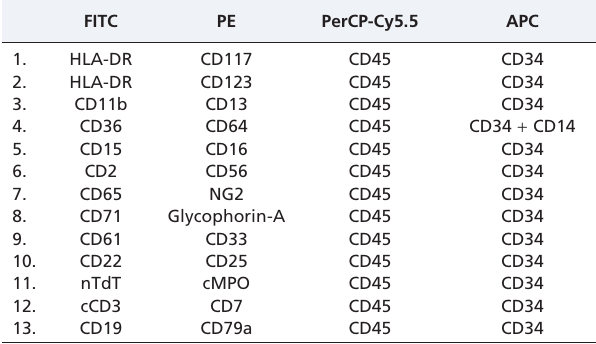
Table 1 - Monoclonal antibody reagents used for the immunophenotypic characterization of myelodysplastic syndrome (modified from Matarraz S. et al., Leukemia 2008;22:1175-83) (5).